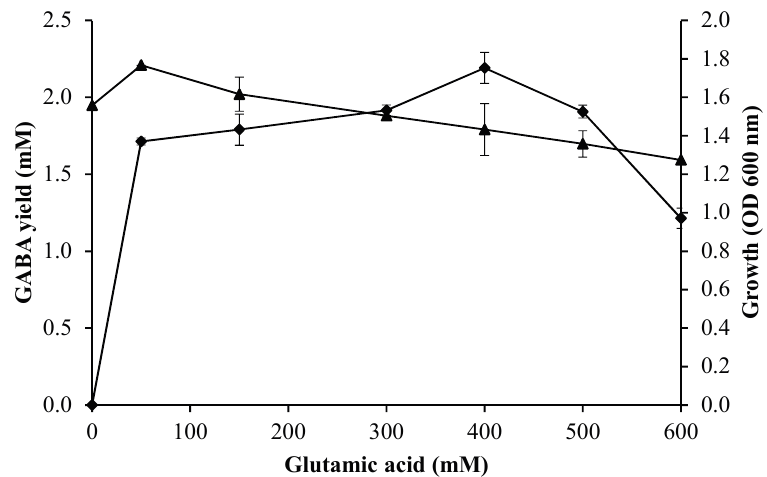
Figure 5. Effect of initial glutamic acid concentration on growth profile and GABA production of Lactobacillus plantarum Taj-Apis362. Culture conditions were fixed as follows: pH, 5; temperature, 30 °C; and incubation time, 60 h. Symbols: ( ▲ ) growth; ( ♦ ) GABA. The vertical bars represent the SD from 3